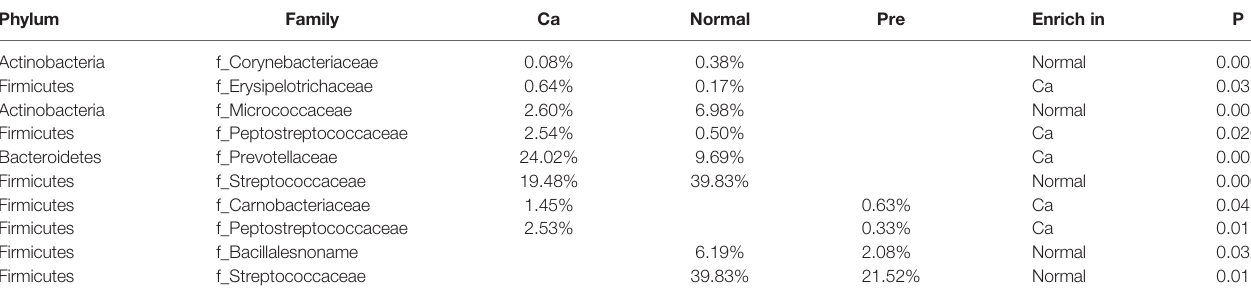
TABLE 2 | Abundances of dominant families with signi fi cant differences among the three groups as calculated using STAMP. Phylum